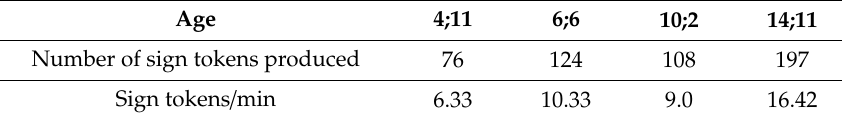
Table 2. Comparison of quantity of signs produced and error rates across time